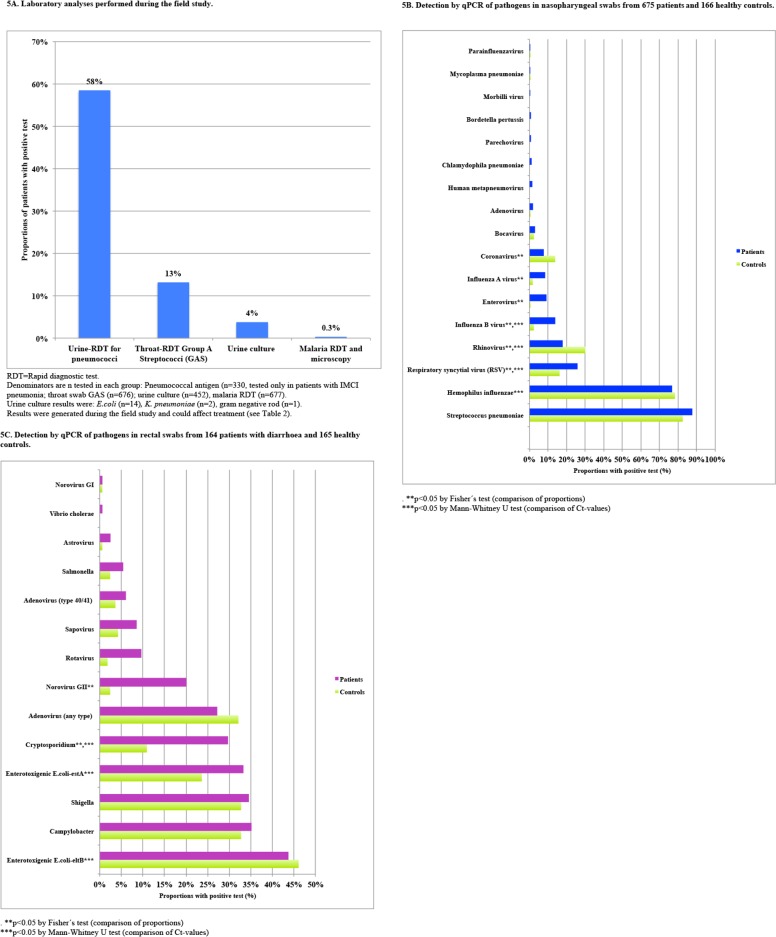
ABC. Pathogen detection in samples collected on enrolment day.